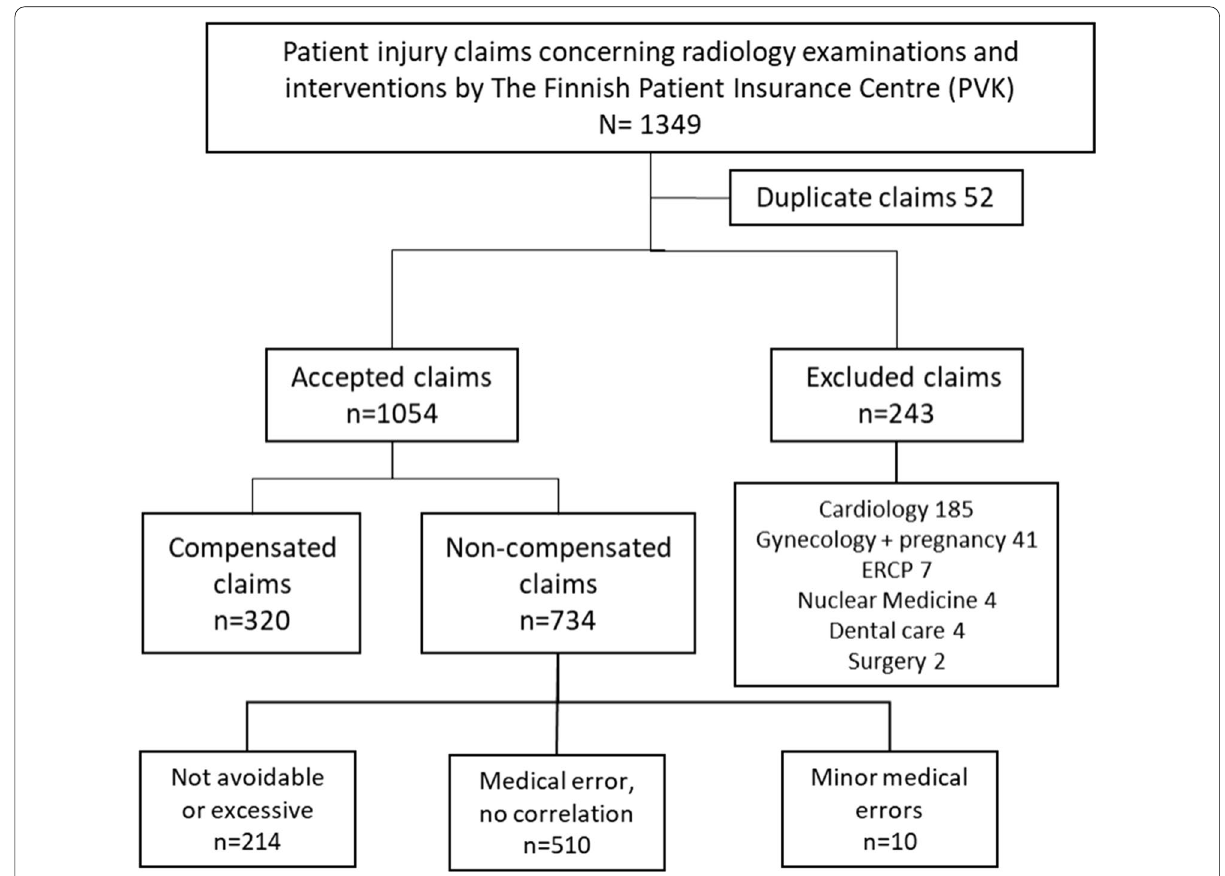
Fig. 1 Flowchart of patient injury data